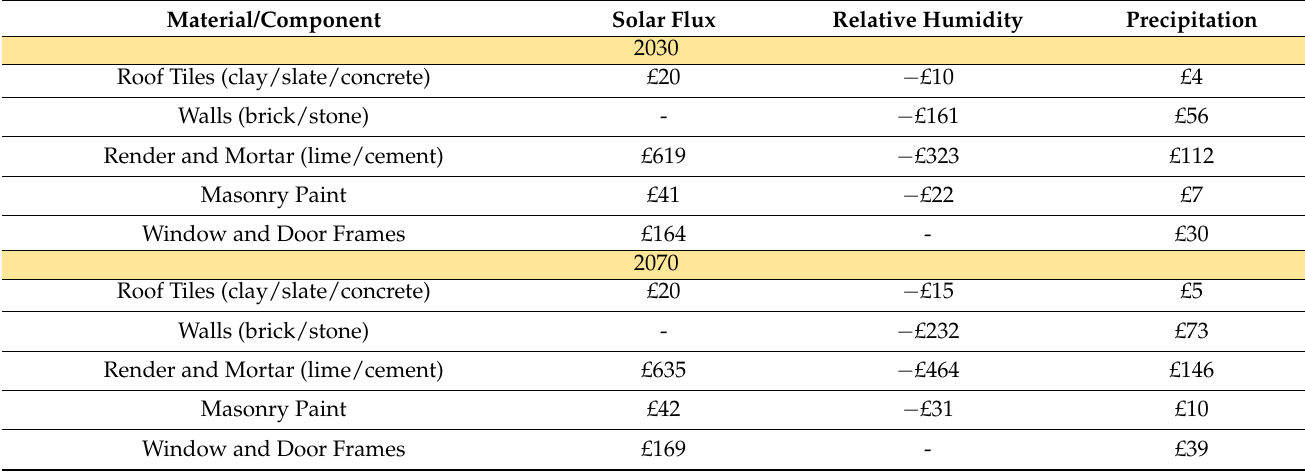
Table 4. Change in replacement costs by dwelling over the life of the building